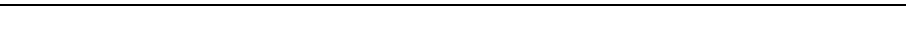
associated with the weighted entangled connections for the entanglement swapping procedure.